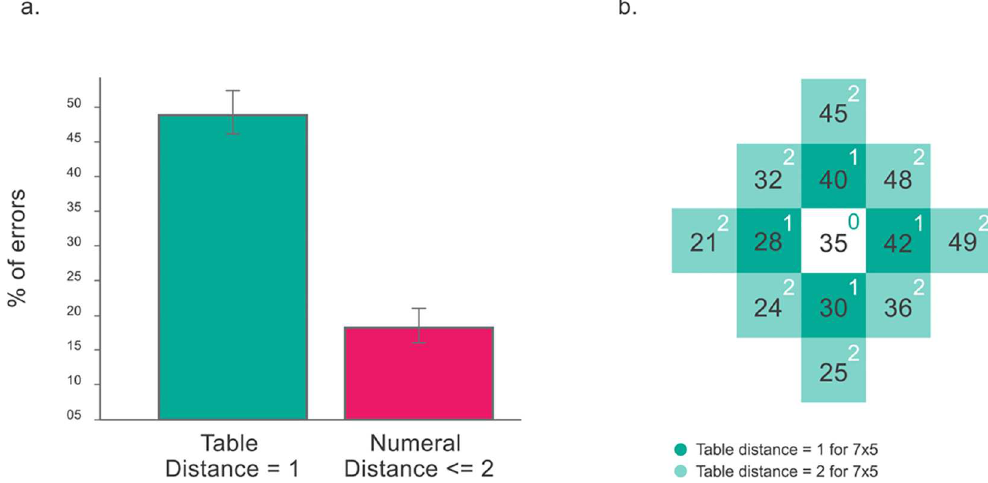
Fig 8. (a) Most errors correspond to one of the four possibilitiesgiven by a table distance= 1. For a fair comparison againsta possibilitywith four different results, we also plot the errors correspondingto numerical distance < = 2. Inter-subjects SEs are also shown. (b) Figure explainingthe concept of table distancefor the 7x5 problem. The numbersin dark green are separatedby a table distanceof 1 and in light green by